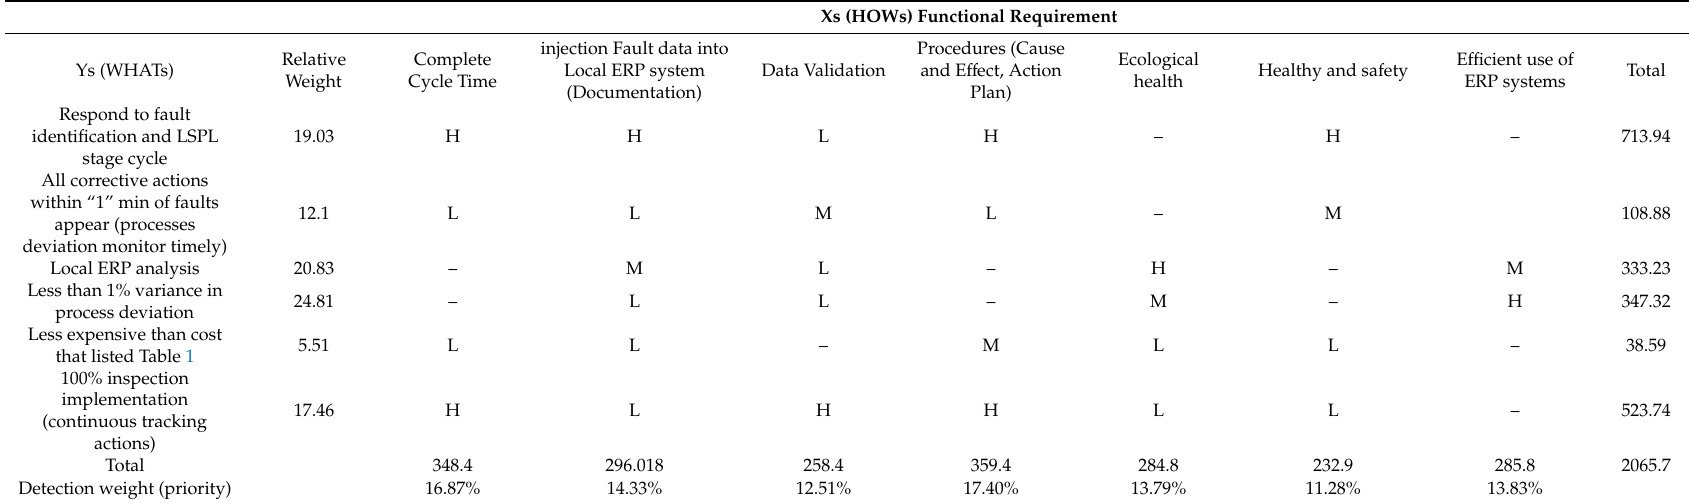
Table 6. Safety Function Deployment (Step